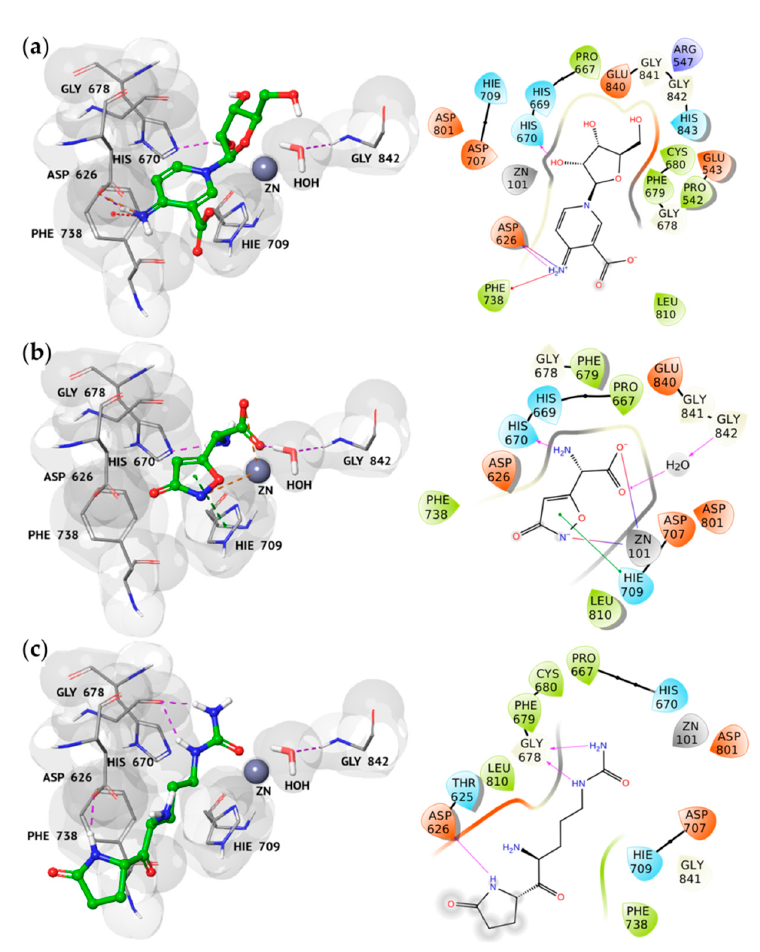
Figure 1. 3D and 2D representations of the best hits 1 ( a ), (S)-2 ( b ), and 3 ( c ) complexed to HDAC7 (PDB code 3C10), respectively. Protein is shown as grey surface, ligands are displayed as green carbon ball-and-sticks, while the amino acid residues involved in the molecular interactions are reported as grey carbon sticks. In the 2D representations, H-bonds, salt bridges, stacking, and π -cation interactions are depicted as violet, orange, green, and red lines, respectively.